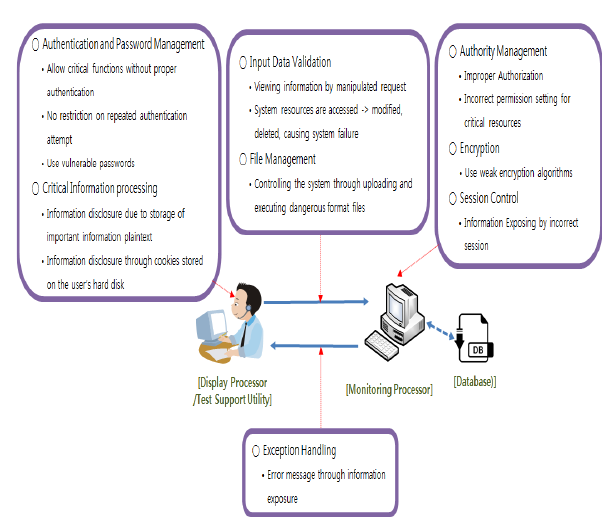
Fig. 9 Expected Security Vulnerabilities of the Prototype